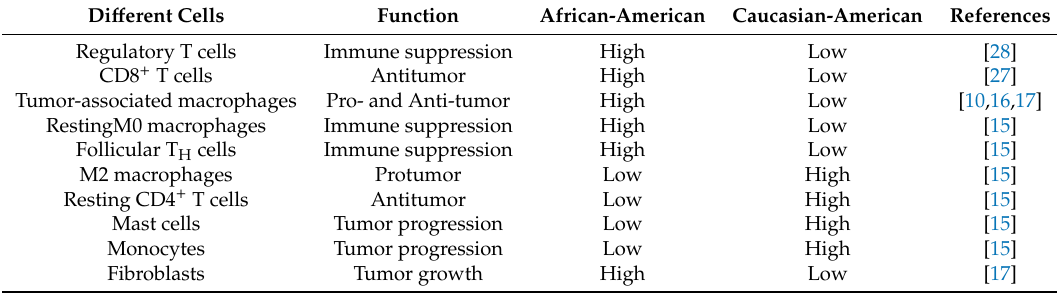
Table 1. Disparate regulation of di ff erent cells in breast